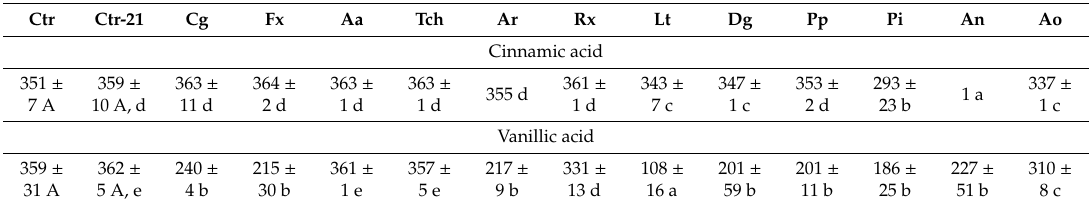
In line, di ff erent uppercase letters indicate significant di ff erences between the control and control after 21 days ( p < 0.05). In line, di ff erent lowercase letters indicate significant di ff erences between the control after 21 days and the media inoculated with fungi.